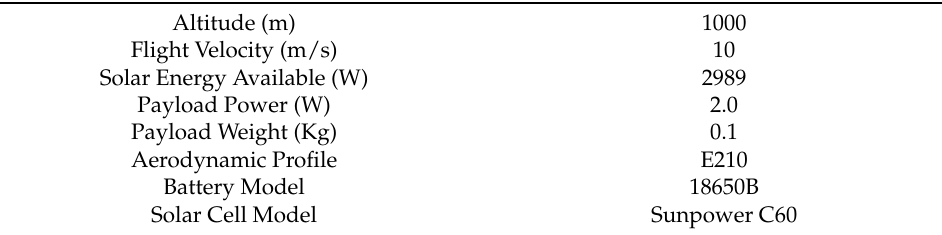
Table 7. Mission parameters for proposed mission.